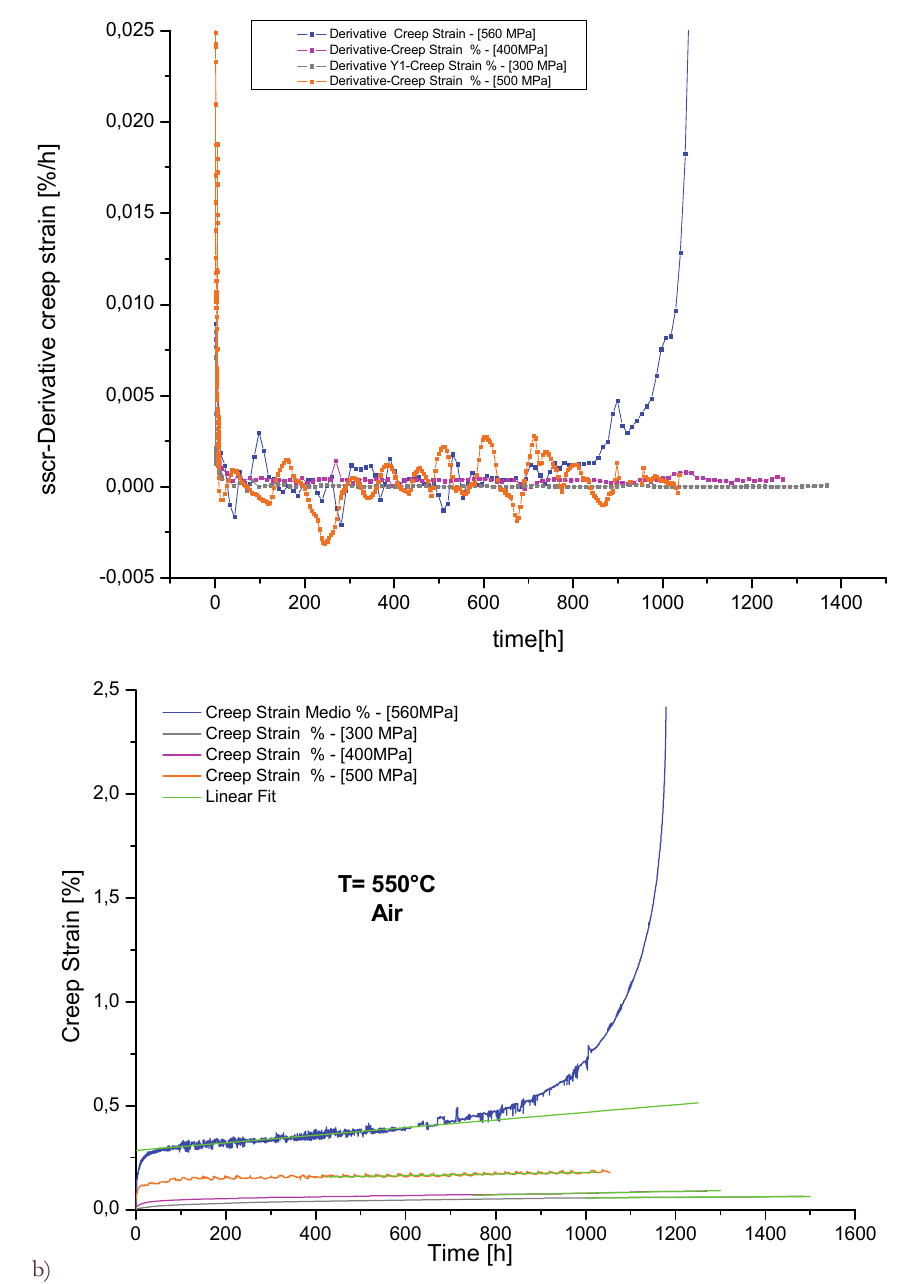
Figure 6: sscr calculus: minimum of first derivative (a) and fit linear of secondary creep stage